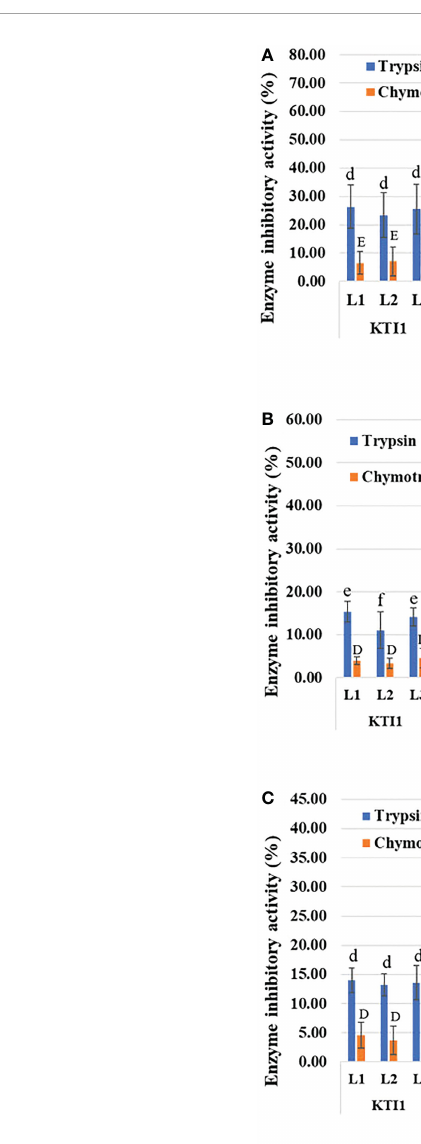
(Figure 3A). Transgenic Arabidopsis lines of KTI1 (an average of 2.5-